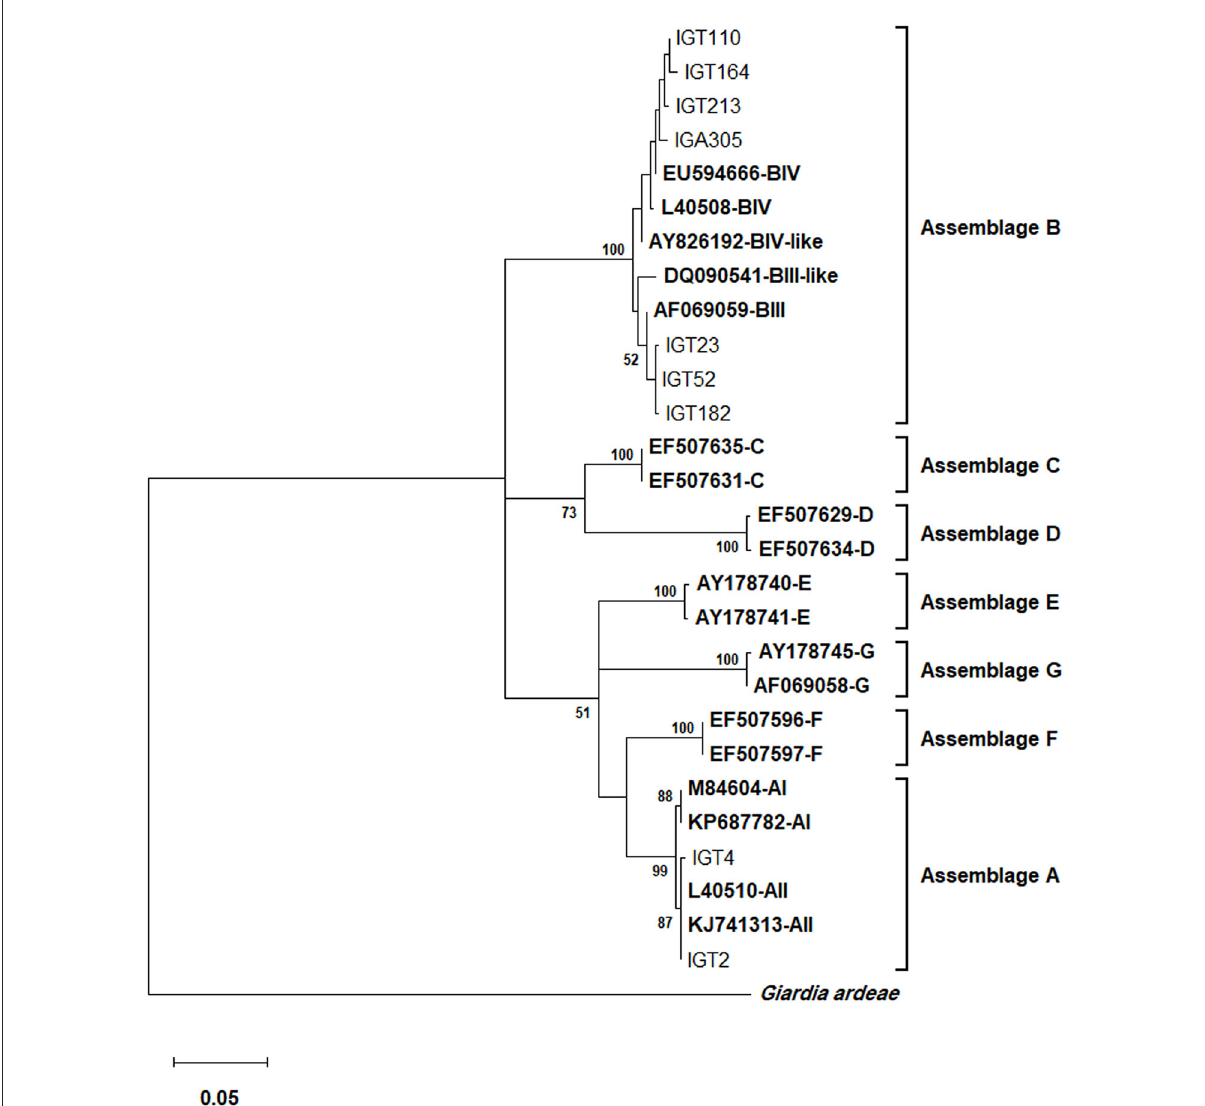
FIGURE3 The phylogenetic analysis of the gdh gene nucleotide sequences of Giardia duodenalis using the Maximum Likelihood method and Tamura 3-parameter model (38) (T92 + G + I model). This analysis involved 29 nucleotide sequences: Nine representative nucleotide sequences of gdh retrieved from this study (LC184423–LC184474) compared with 19 reference sequences of known assemblages from Genbank (indicated in bold) with Giardia ardeae as an outgroup. The percentage of trees in which the associated taxa clustered together (achieved from 1,000 replicates) is shown next to the branches, only bootstraps values > 50% are demonstrated. A discrete Gamma distribution was used to model evolutionary rate differences among sites [5 categories ( + G , parameter = 0.4823)]. The rate variation model allowed for some sites to be evolutionarily invariable [( + I ), 36.49% sites]. The scale bar represents substitutions per nucleotide. A total of 433 positions were evaluated in the final dataset. Evolutionary analyses were conducted in MEGA X (39).